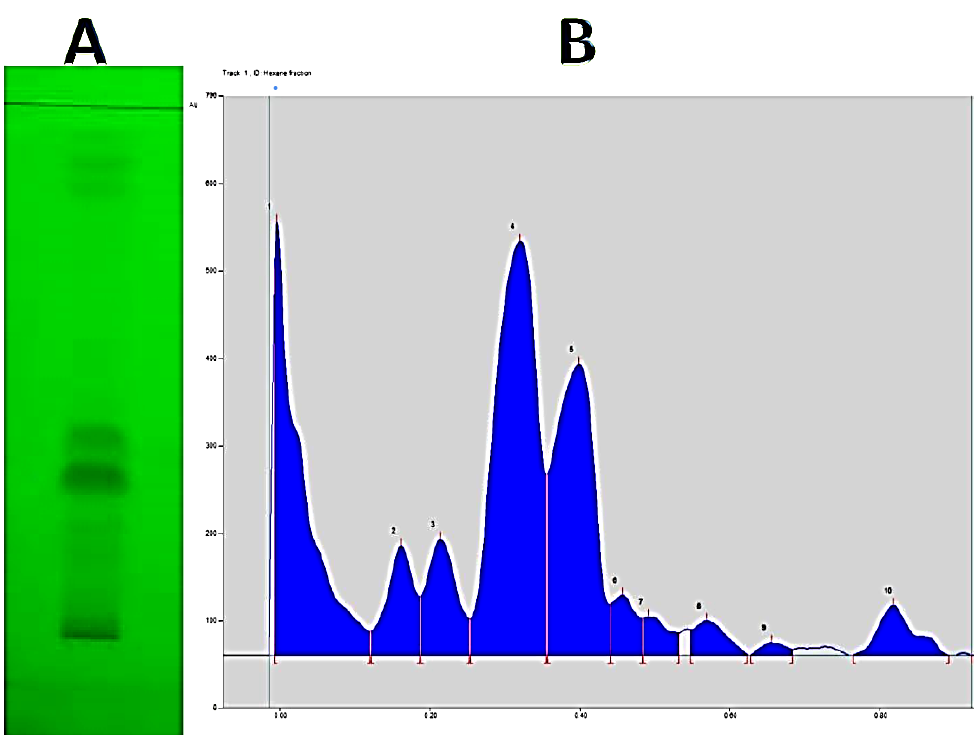
Figure 2. UV illumination at 365 nm ( A ) of a normal TLC plate developed in a solvent mixture of petroleum ether: EtOAc (9.3:0.7, v/v ) and Scanning of TLC chromatogram ( B ) using CAMAG TLC Scanner .